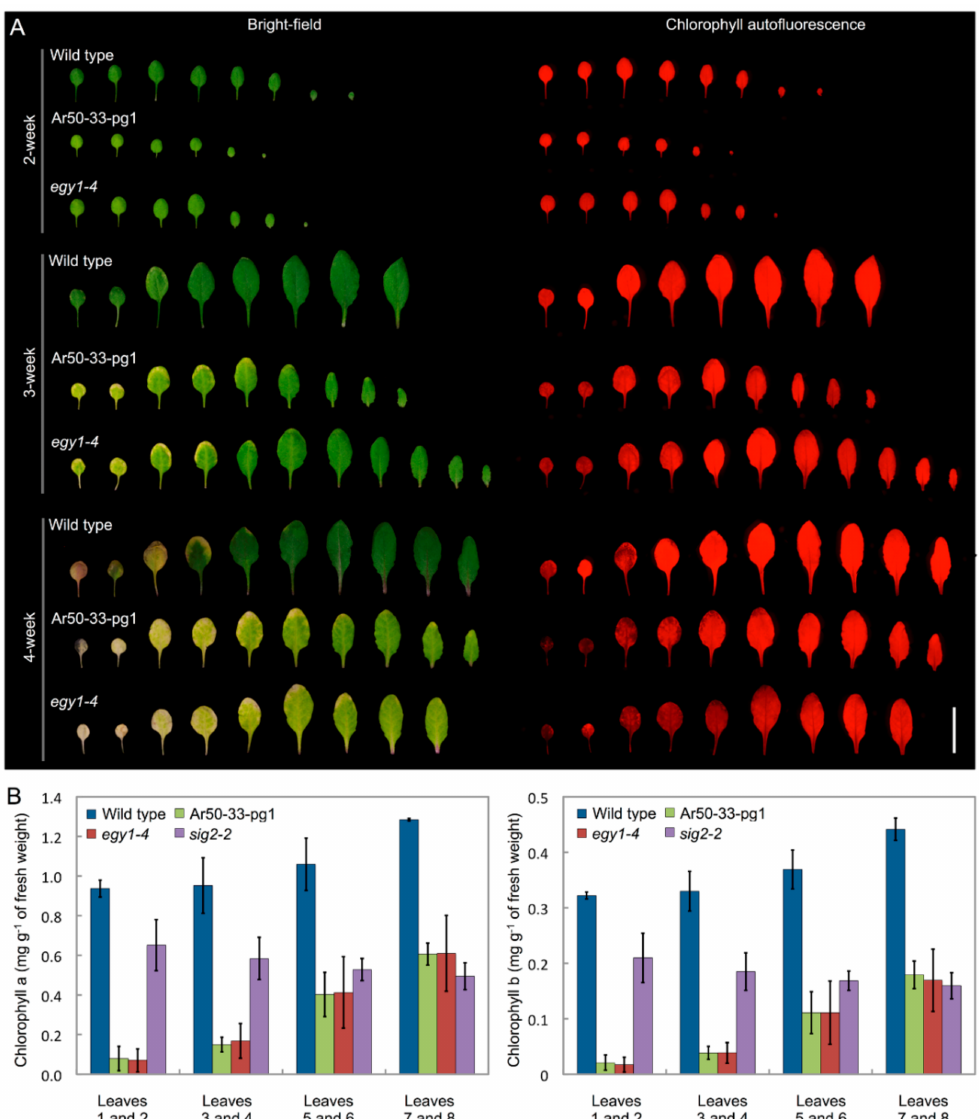
Figure 3. Leaf phenotypes of wild type and mutant plants. ( A ) Bright-field and chlorophyll autofluo- rescence images of detached leaves from 2-, 3- and 4-week-old wild type, Ar50-33-pg1, and egy1-4 plants (from left to right: oldest to youngest leaves). Bar = 2 cm. ( B ) Measurement of chlorophyll a and chlorophyll b in wild type, Ar50-33-pg1, egy1-4 , and sig2-2 leaves. Three independent experiments were performed using 4-week-old leaves (error bars represent the